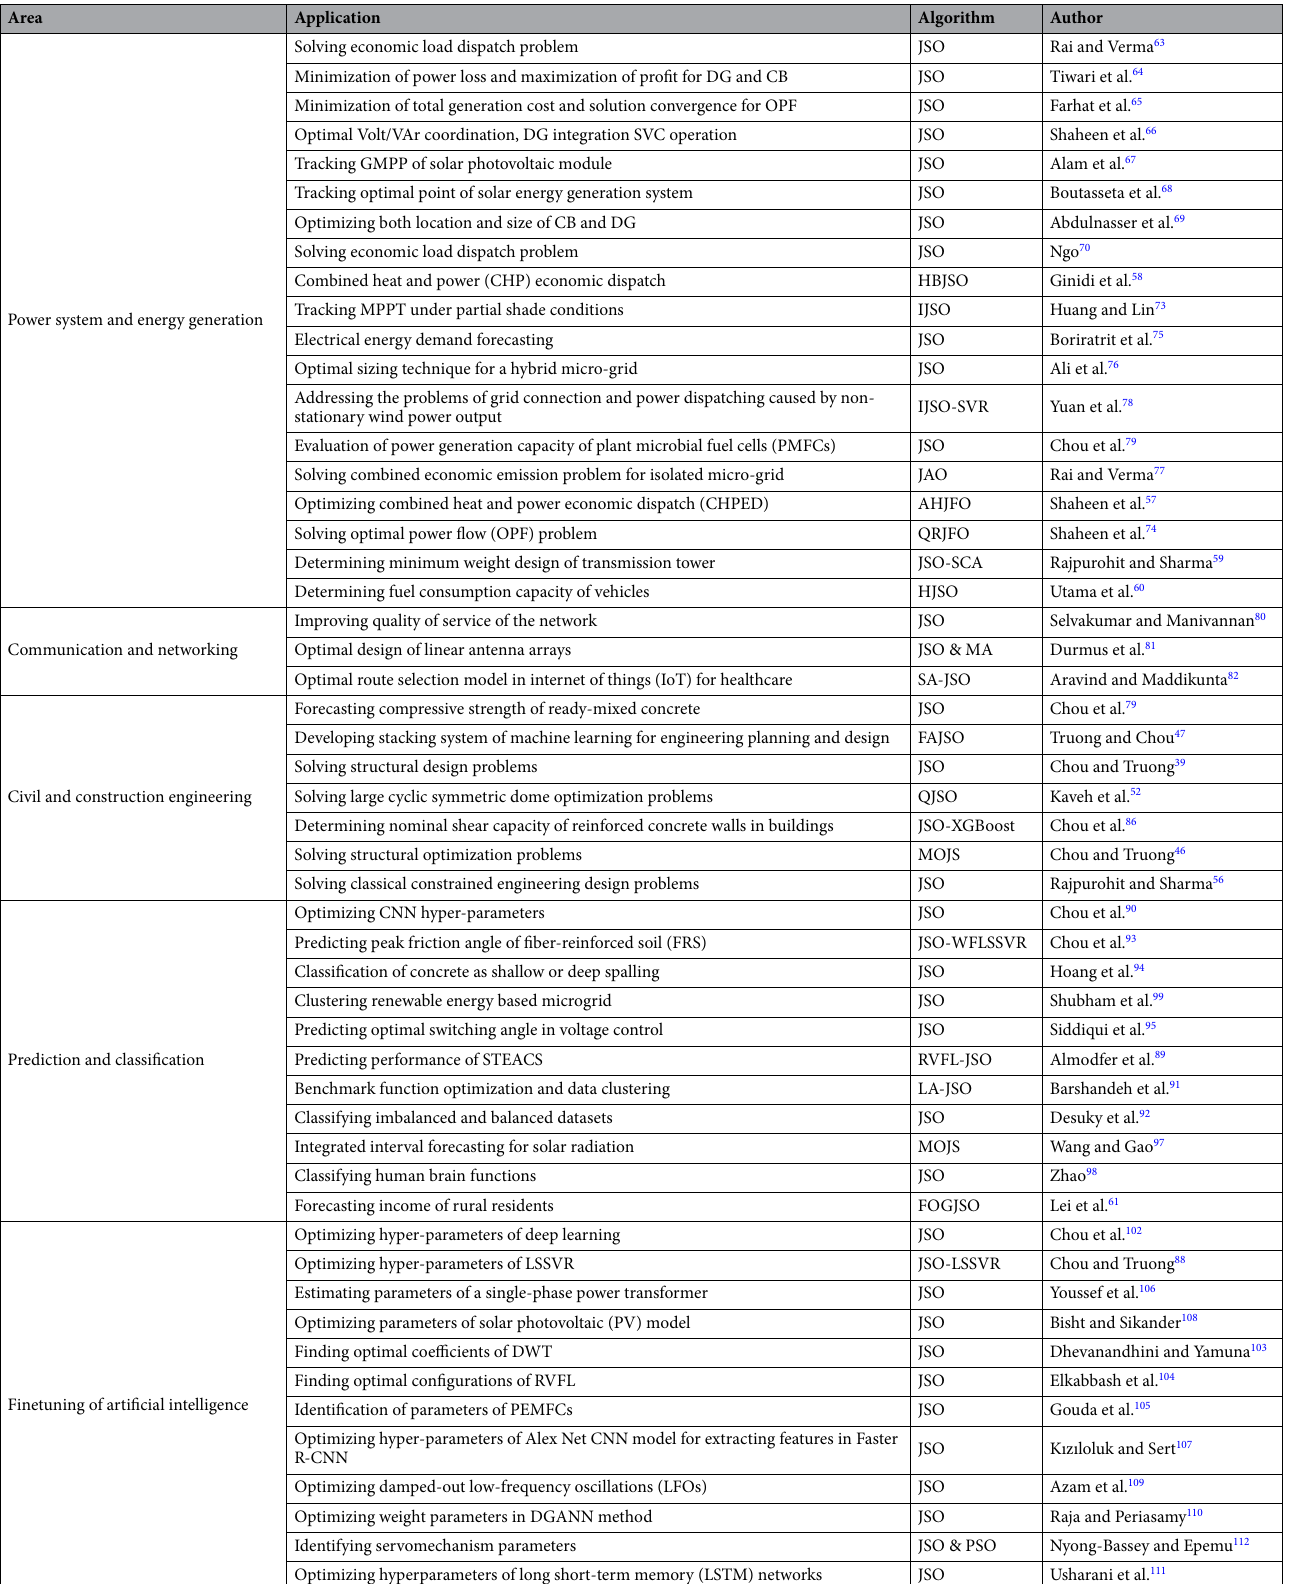
Table 2. Applications of jellyfish search optimizer in various